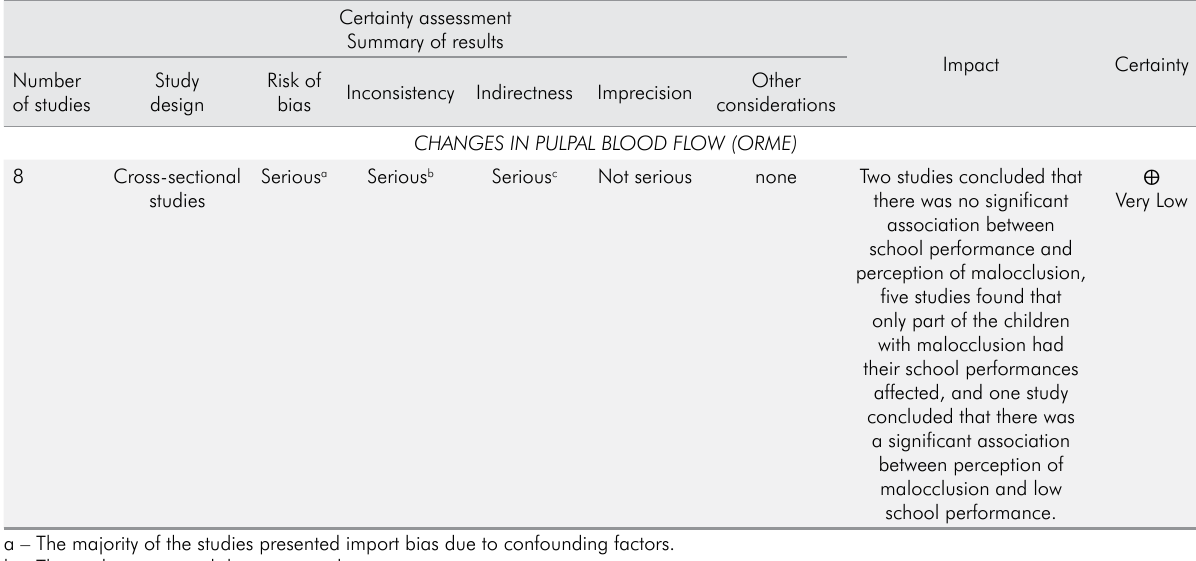
Table 7. Summary of findings by the Grading of Recommendations Assessment, Development, and Evaluation (GRADE) for the outcomes of the systematic